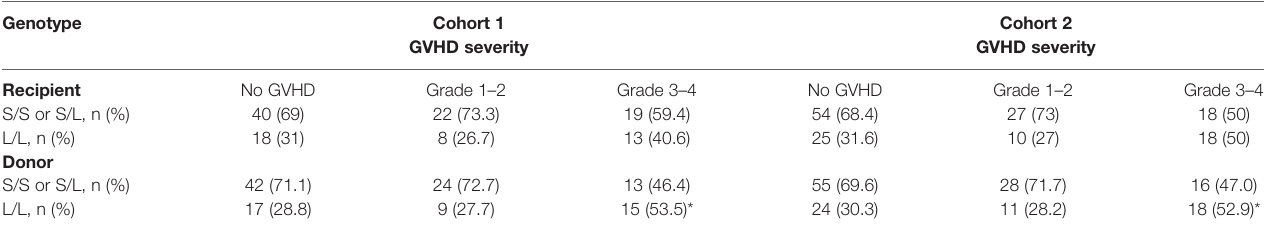
*Clinical data for GVHD severity are incomplete for eight patients in cohort